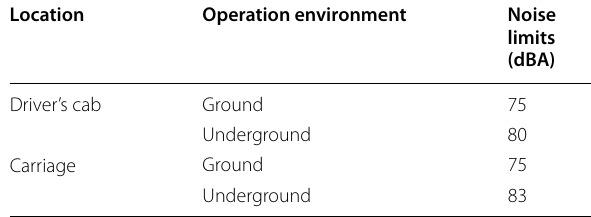
Table 1 Metro vehicle interior noise limits [19]